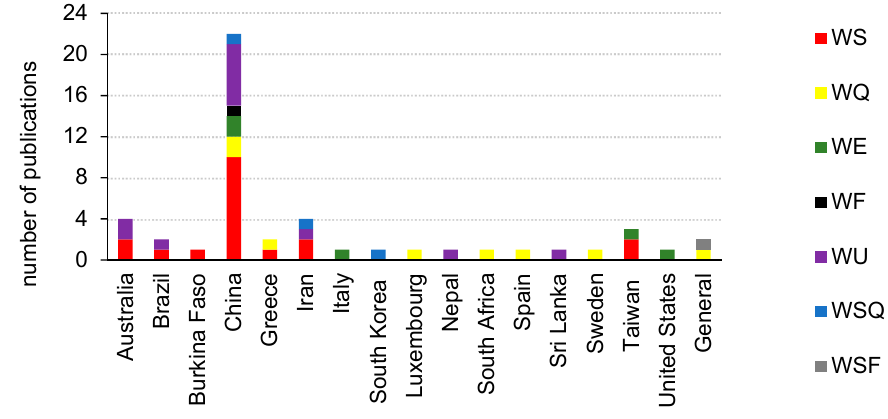
Figure 8. Distribution of publications based on water problems across the study regions.